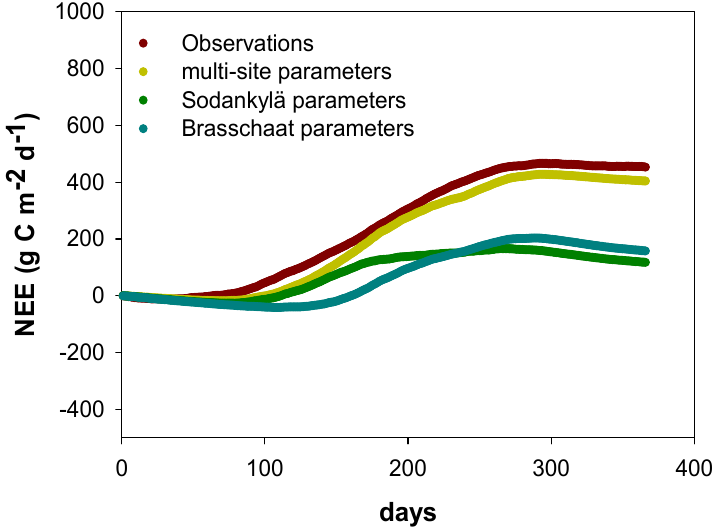
Figure 4. Cumulative daily mean values of the period 2001–2010 of Net Ecosystem Exchange (NEE) obtained with multi-site, boreal and temperate parameters calculated with the specifications of the pine forest of